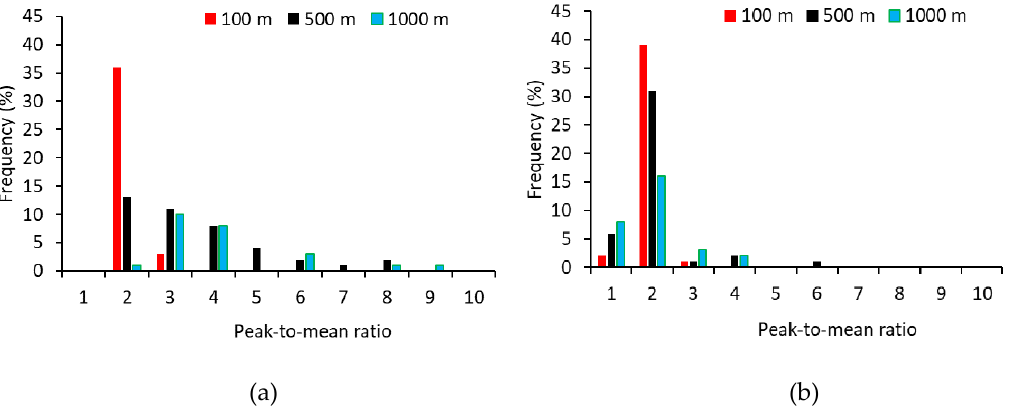
Figure 6. Frequency distribution of the peak-to-mean ratio of odour intensity along the wind direction at 100, 500, and 1000 m from the odour source. ( a ) PMR_OI (true peak-to-mean ratio of odour intensity) and ( b ) CPMR_OI (conditioned peak-to-mean ratio).